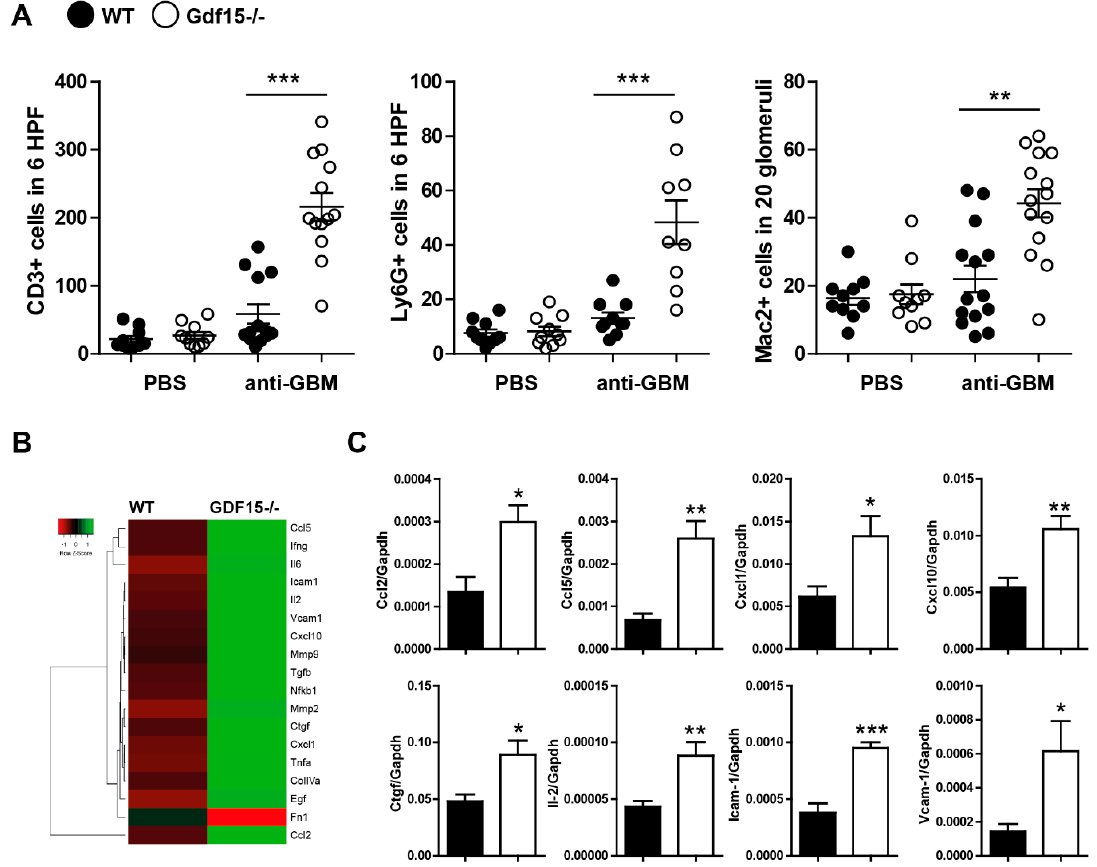
Figure 4. Kidney inflammation in wild type and Gdf15 KO mice with anti-GBM nephritis. ( A ) Kidney sections were stained with anti- CD3, Ly6G, or Mac2 antibodies and quantified by counting, as indicated on graphs and in material and methods ( n = 9–15 mice per group, one-way ANOVA). ( B ) Heat map depicting kidney expression of pre-selected genes of wild type and GDF15-deficient mice upon anti-GBM serum treatment. ( C ) Gene expression levels in kidneys were quantified by real-time PCR. Data are shown as means of the ratio of the specific mRNA vs. that of Gapdh mRNA ( n = 6–8 samples per group, Student’s t -Test). Data are mean ± SEM. * p < 0.05; ** p < 0.01; *** p < 0.001 versus control mice.